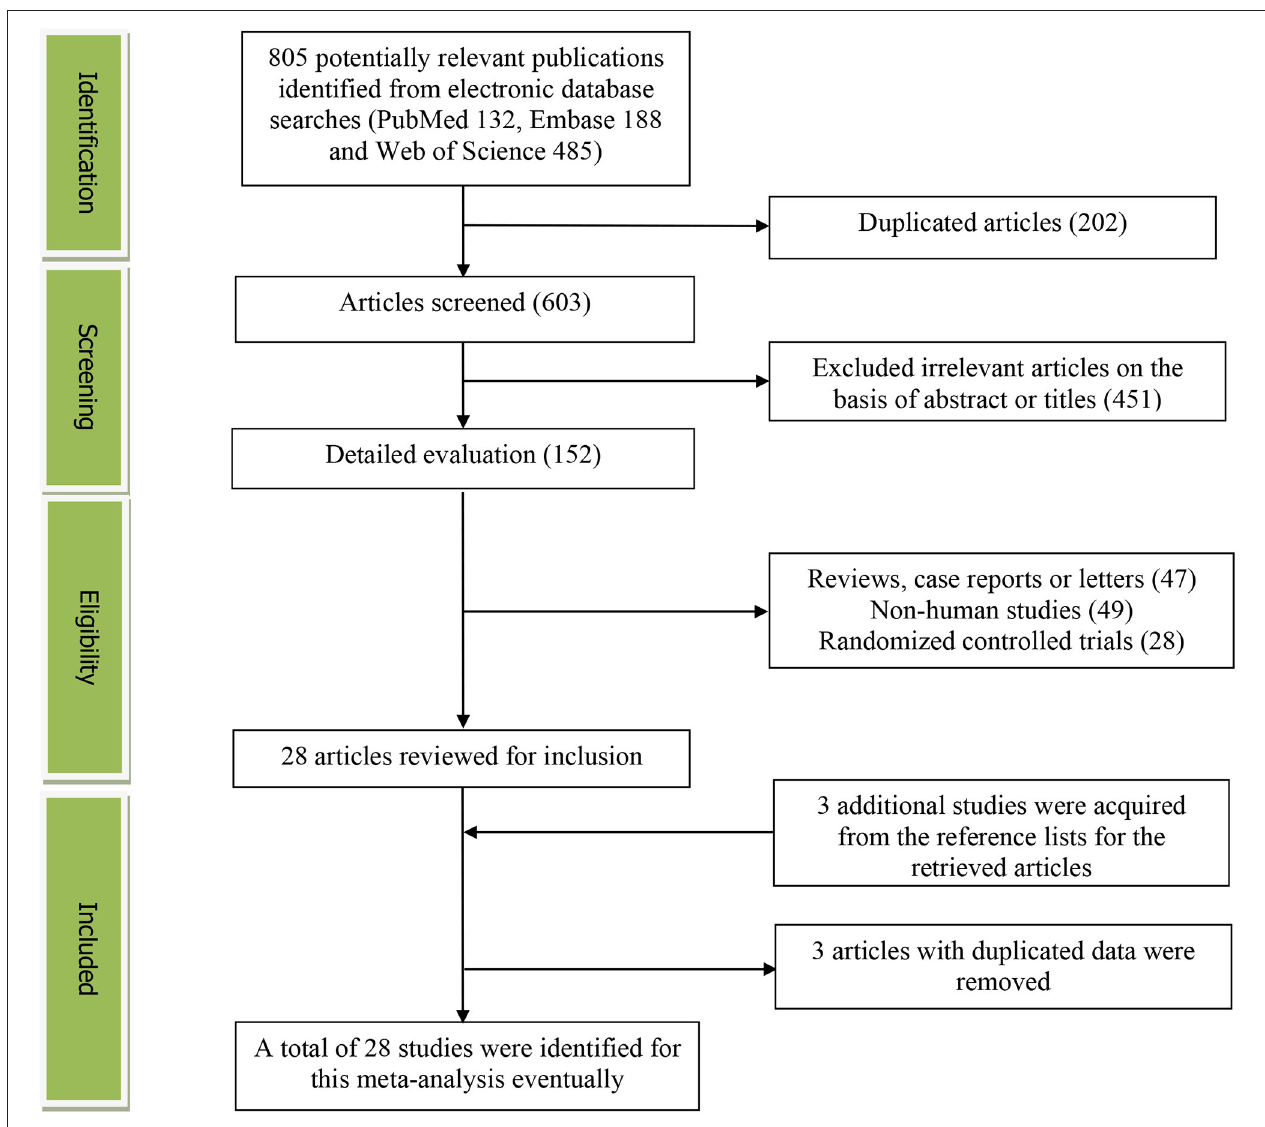
FIGURE 1 | The detailed flow diagram of the study identification and selection in this